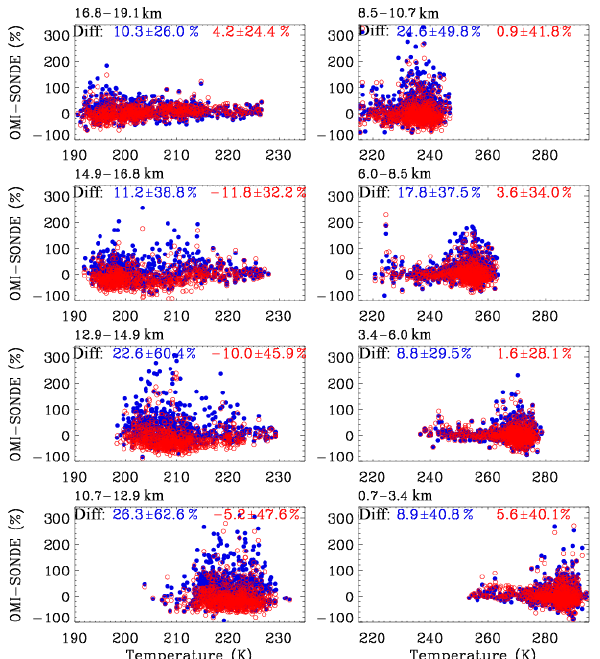
Figure 10. Scatter plots of individual differences between OMI retrievals using BDM (blue) and BW (red) cross-sections and ozonesonde measurements for each layer from the surface (bot- tom right) to 19.1km (top left) as functions of layer temperature. Mean differences and standard deviations for both cross-sections are shown in the